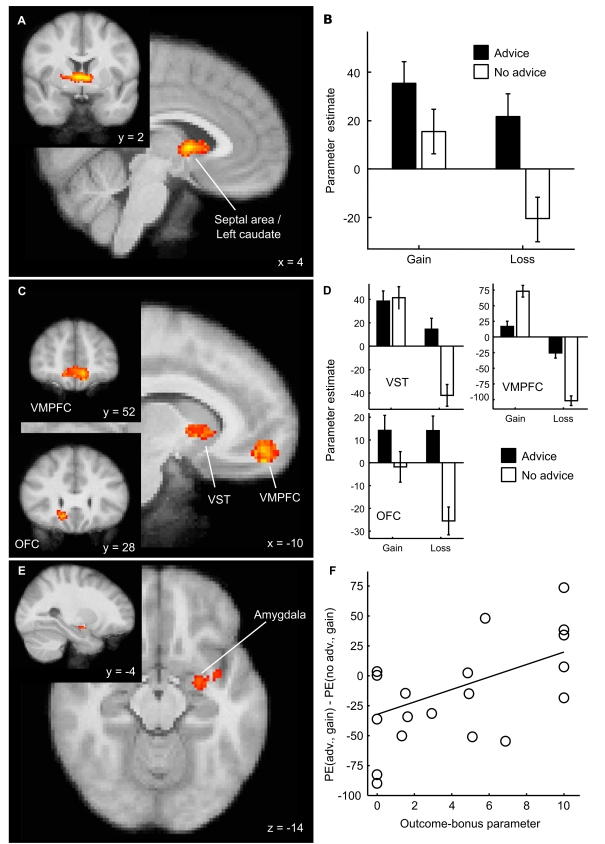
Neural basis of an outcome-bonus after following advice.(A) Feedback after following advice led to greater activity in the left caudate head and septal area. (B) Parameter estimates (PE) of the General Linear Model analysis suggest that the outcome-bonus is implemented in the septal area and left caudate as a greater increase in BOLD signal for gains and as a smaller decrease in BOLD signal for losses after following advice. (C and D) VST, VMPFC, and OFC showed a greater reduction in BOLD response to negative outcomes if these followed deviation from advice. (E) Participants with higher outcome-bonus parameters showed greater increases in BOLD signal in the left lateral amygdala for gains after following advice compared to after not following advice. (F) Scatter plot illustrating this correlation (1 outlier participant removed). Note that all regions implementing the outcome-bonus are gain preferring after not following advice, in that they all show an increase in BOLD signal to gains and a decrease in BOLD signal to losses.